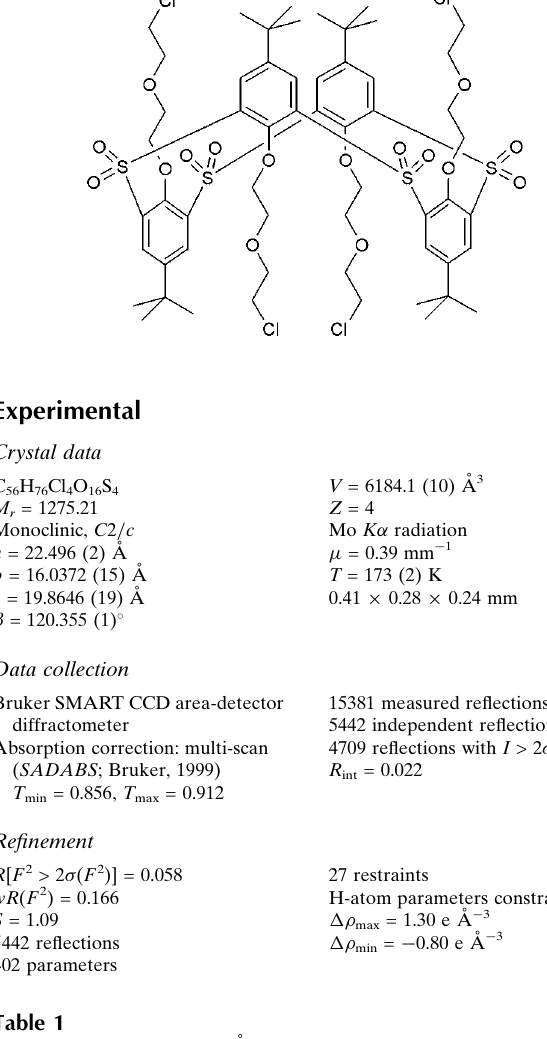
Hydrogen-bond geometry (A˚ , (cid:1)